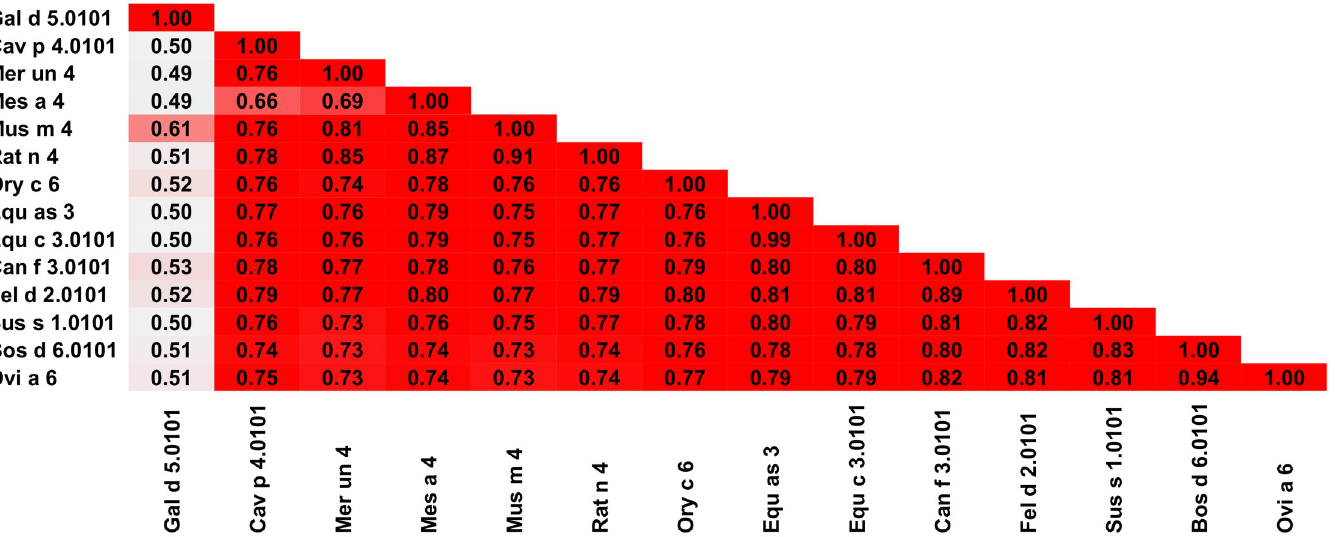
Fig 8. Plot showing A-RISC index values for allergen pairs from the serum albumin family of proteins. Red color indicates a high risk of cross-reactivity, a dark green color indicates a low risk of cross-reactivity, and intermediate colors correspond to a medium risk of cross-reactivity.